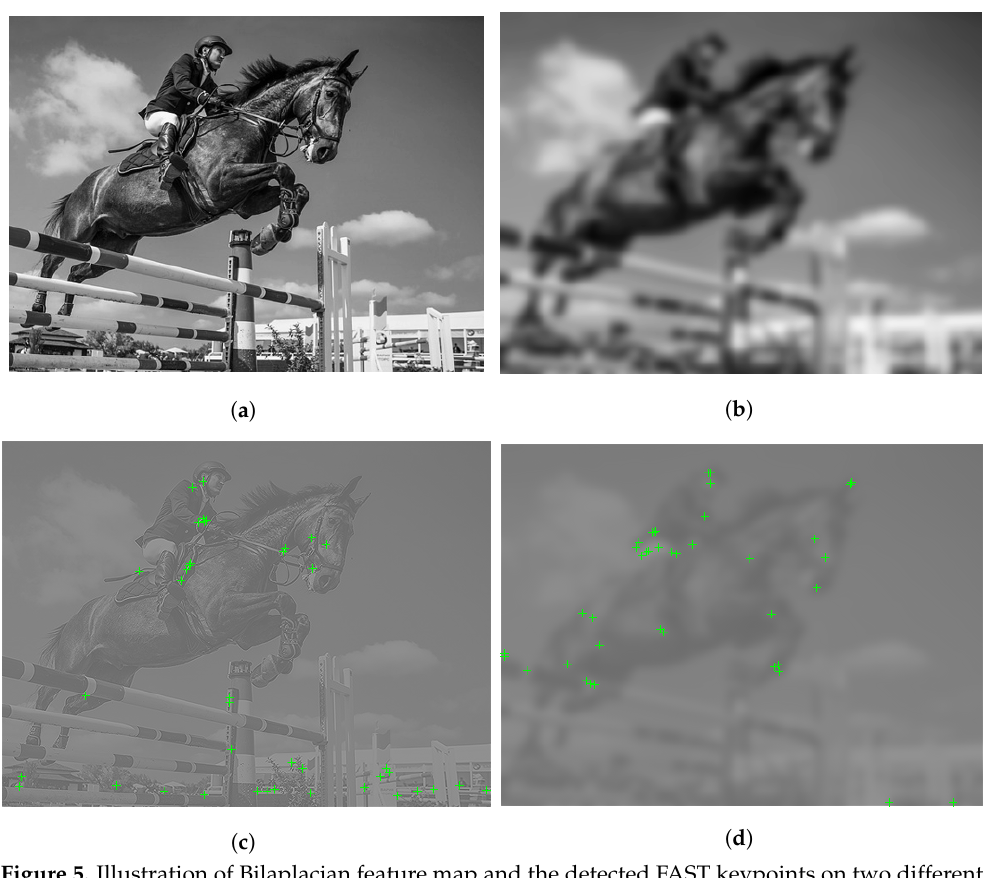
Figure 5. Illustration of Bilaplacian feature map and the detected FAST keypoints on two different distortion levels. ( a ) Luminance channel of pristine image ( Y pristine ) , ( b ) Luminance channel of distorted image ( Y distorted ) , ( c ) Y pristine ∗ L 2 , ( d ) Y distorted ∗ L 2 11 11